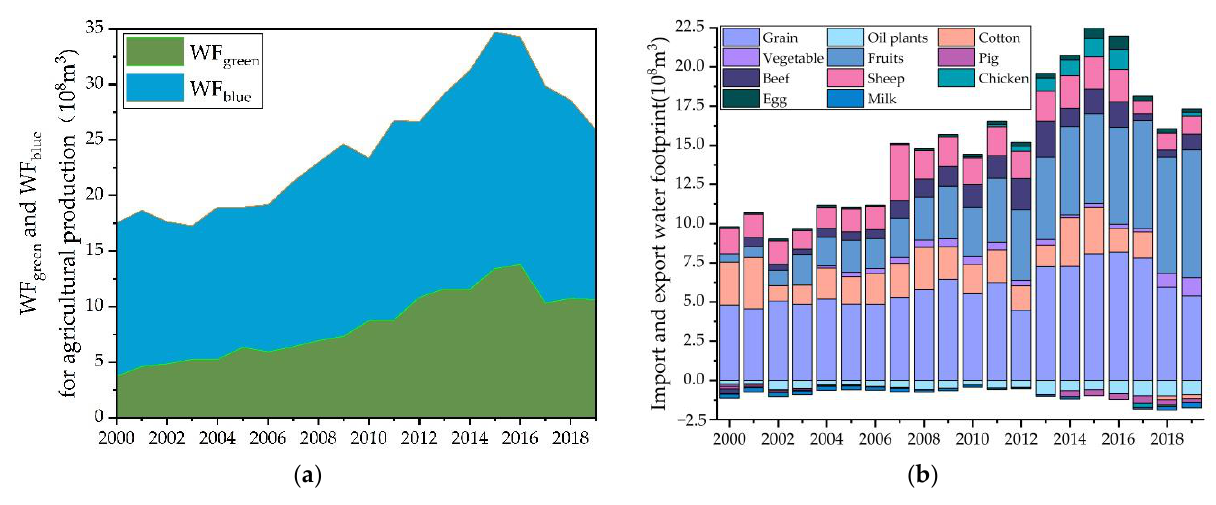
Figure 5. ( a ) WF green and WF blue of agricultural products in Hotan region during 2000 – 2019. ( b ) Import and export water footprint in Hotan region during 2000 – 2019.